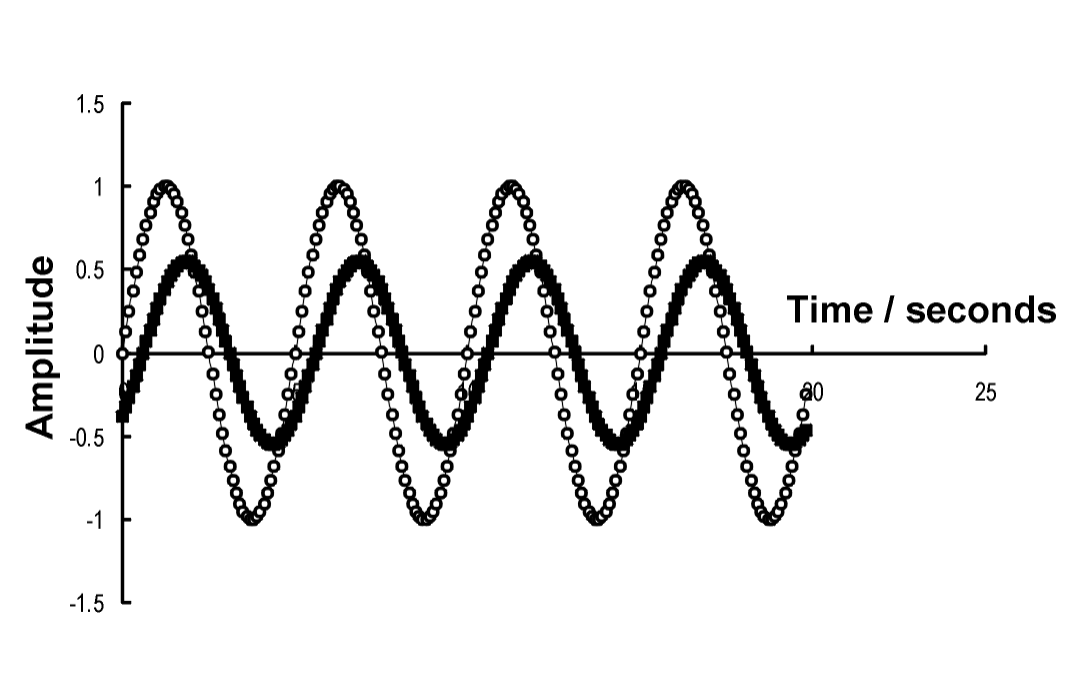
FIGURE 3. Oscillatory strain